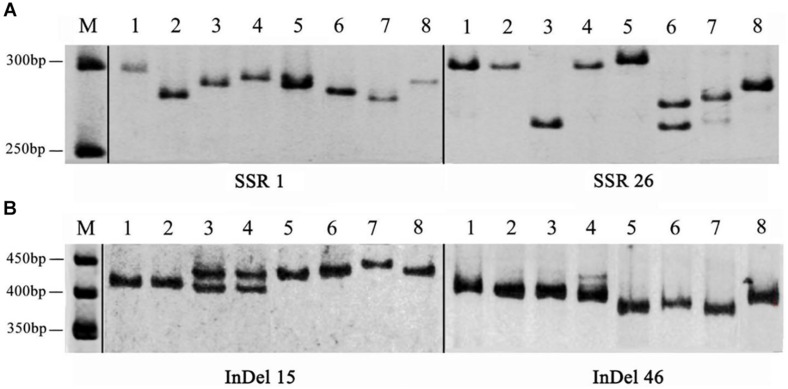
The amplification products of SSR and InDel primers developed from the A. cornea genome. (A) Polymorphic bands between eight A. cornea strains using SSR1 and SSR26. (B) Polymorphic bands between eight A. cornea strains using InDel15 and InDel46.